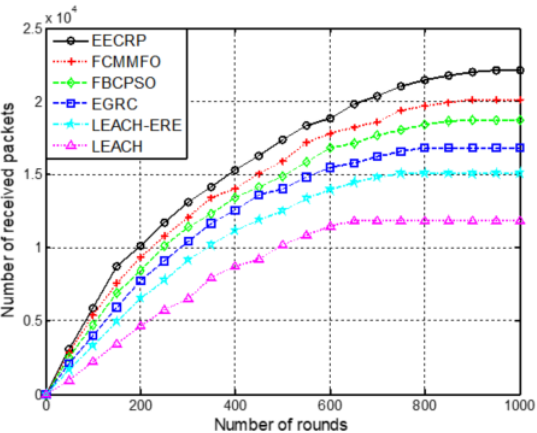
Figure 14. The number of received packets by the sink node (SN) versus the number of rounds for different protocols.